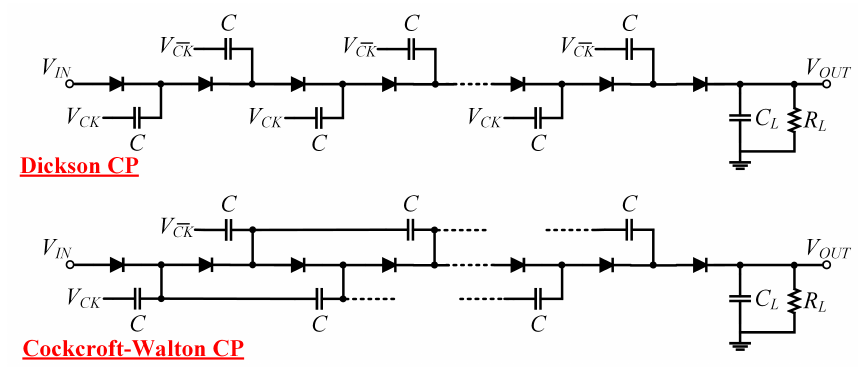
Figure 8. Simplified schemes of Dickson (above) and Cockcroft-Walton charge pumps.